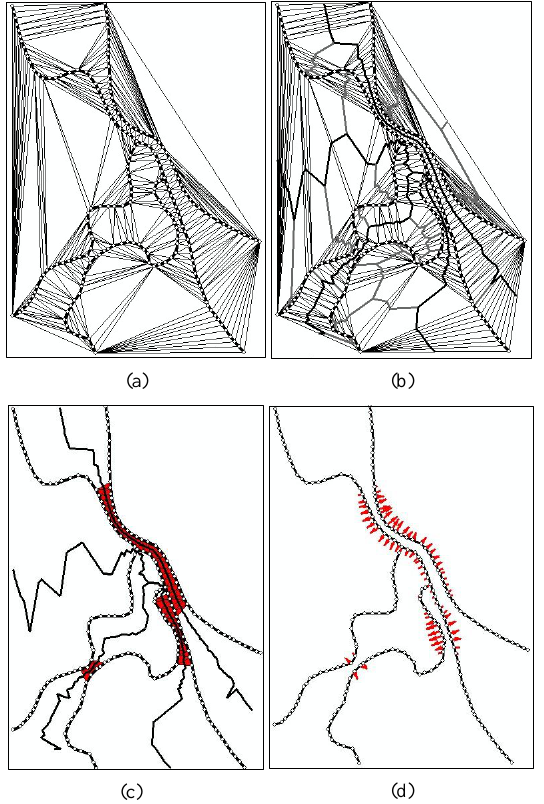
Figure 3. Process of conflict detection and forces calculation: (a) Constructing CDT, (b) Extracting skeleton, (c) Detecting conflicts , and (d) Calculating forces (enlarged 3 times).